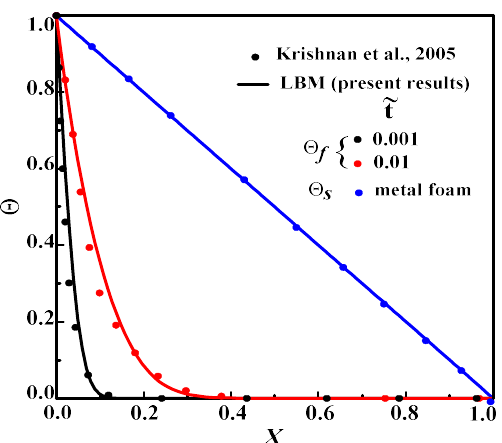
Figure 4. Evolution of dimensionless fluid and solid temperature ( Θ f , Θ s ) vs. dimensionless distance X for Da = 10 − 2 ,Pr = 50, Ra = 10 6 ,Ste = 1,Nu =